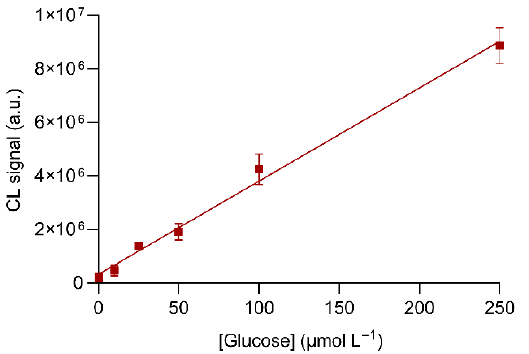
Figure 7. Calibration curve for glucose obtained in the optimized experimental conditions. The equation of the calibration curve is Y = (3.51 × 10 4 ± 2.5 × 10 3 )X + (3.3 × 10 5 ± 3.9 × 10 5 ), R 2 = 0.989, where Y is the CL signal and X is the concentration of glucose ( µ mol L − 1 ). Each value is the mean ± SD of six measures performed in three origami µ PADs.